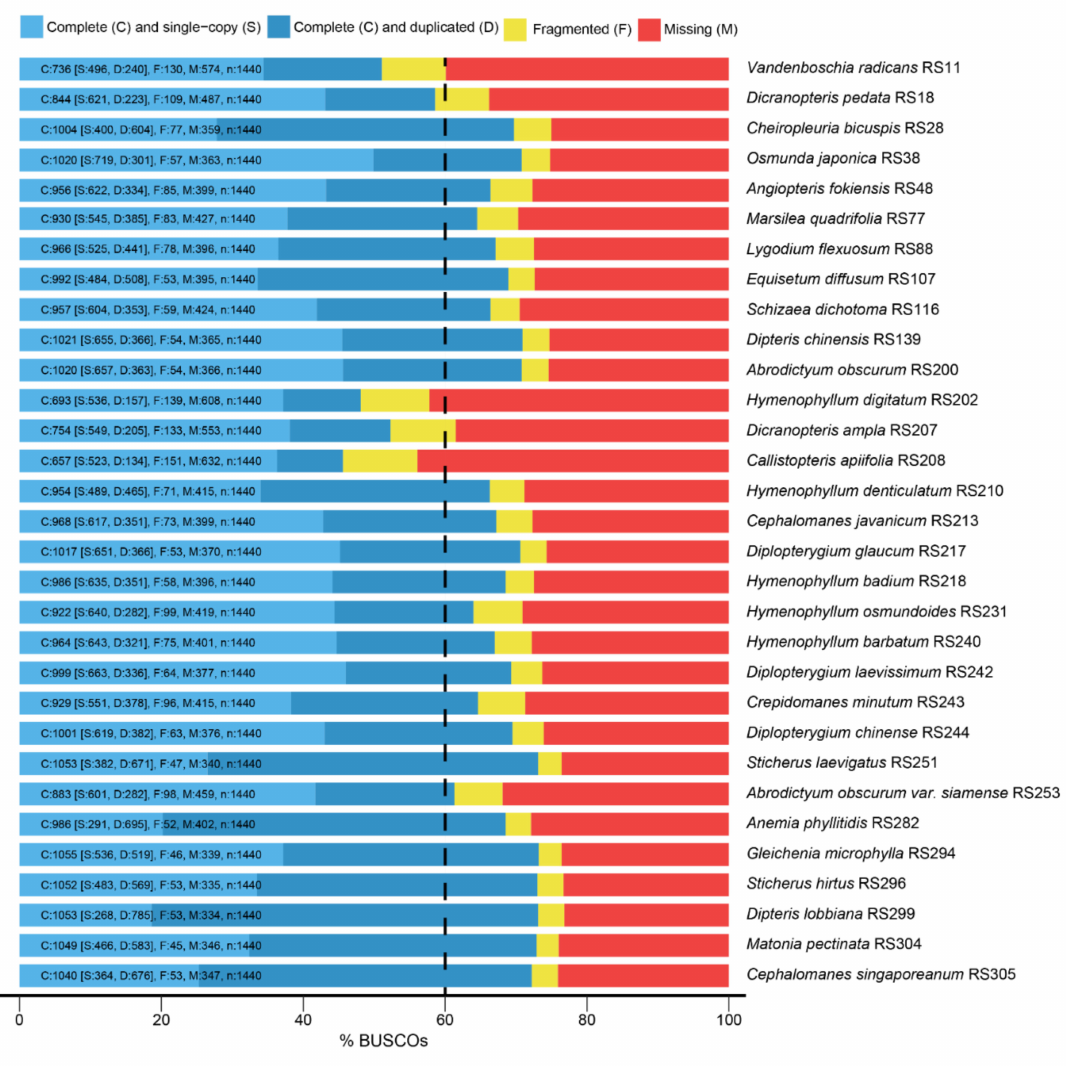
Figure 2. The assessment of transcriptome assembly completeness by Basic Universal Single Copy Orthologs (BUSCOs) analysis. Except for Hymenophyllum digitatum (RS202) and Callistopteris apiifolia (RS208), transcriptome assemblies of the sampled species were complete and orthologs shared more than 60% sequence